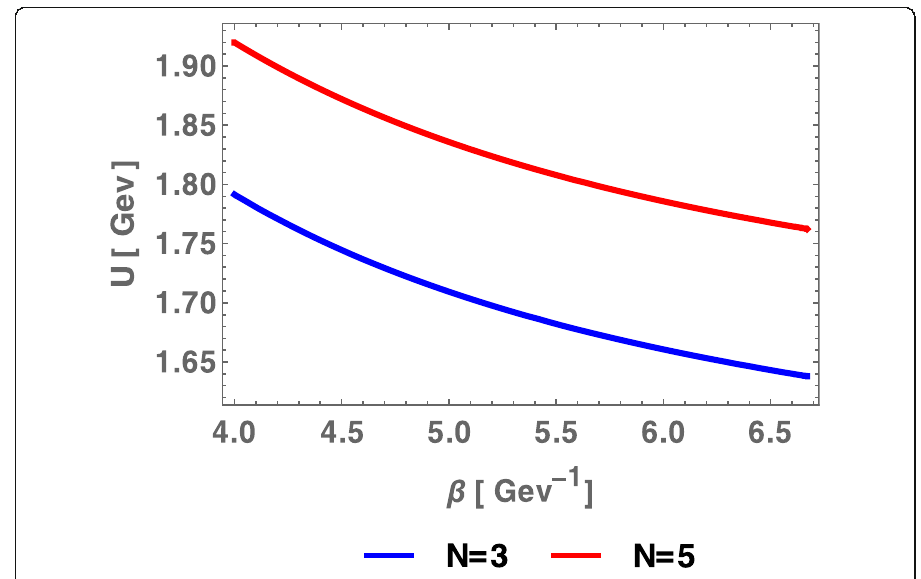
Fig. 4 Internal energy U against β for different values of N